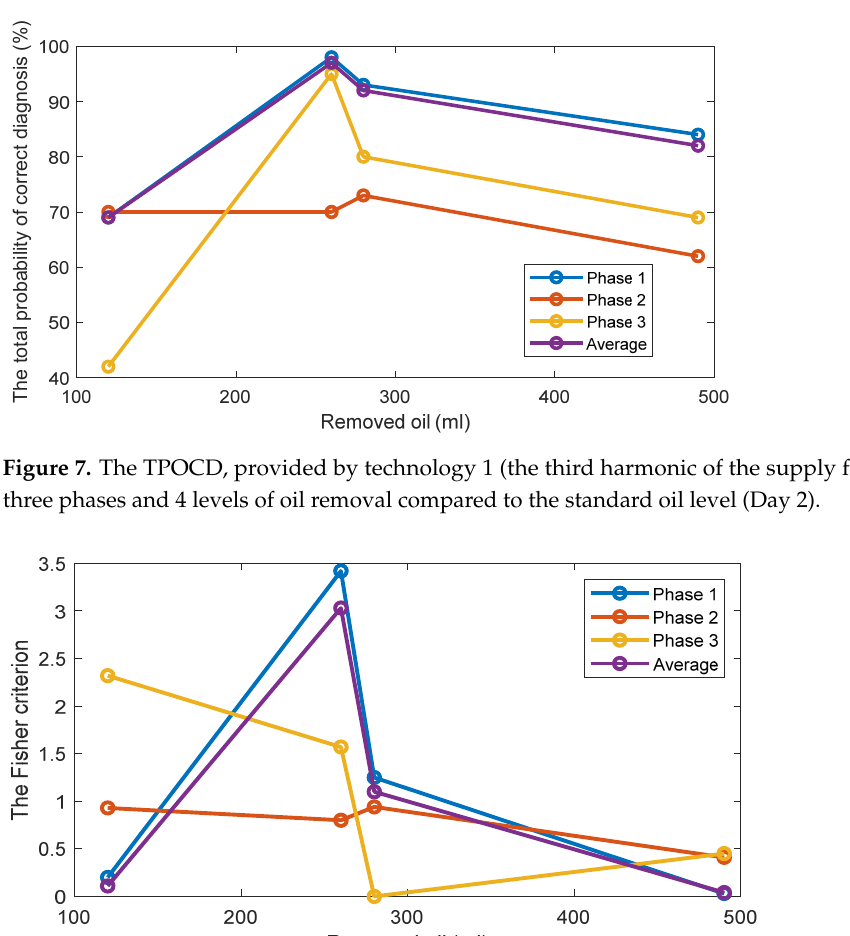
Figure 6. The TPOCD, provided by technology 1 (the third harmonic of the supply frequency), for three phases and 4 levels of oil removal compared to the standard oil level (Day 1).